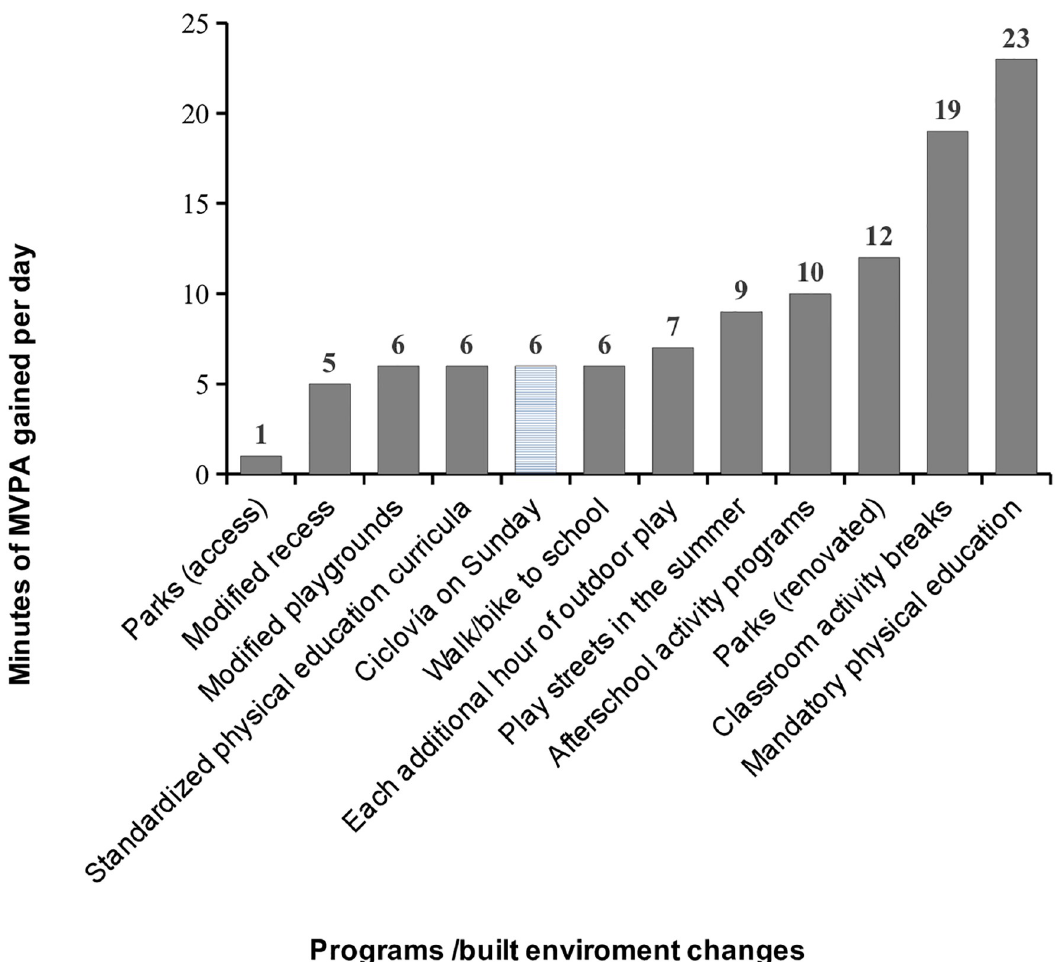
Fig 3. Minutes of moderate-to-vigorous physical activity gained per day resulting from programs and built environment changes. Note: This figure is an adaptation of data presented by Bassett et al[38], D’Haese et al[40] and Denstel et al[39]. MVPA: moderate-to-vigorous physical